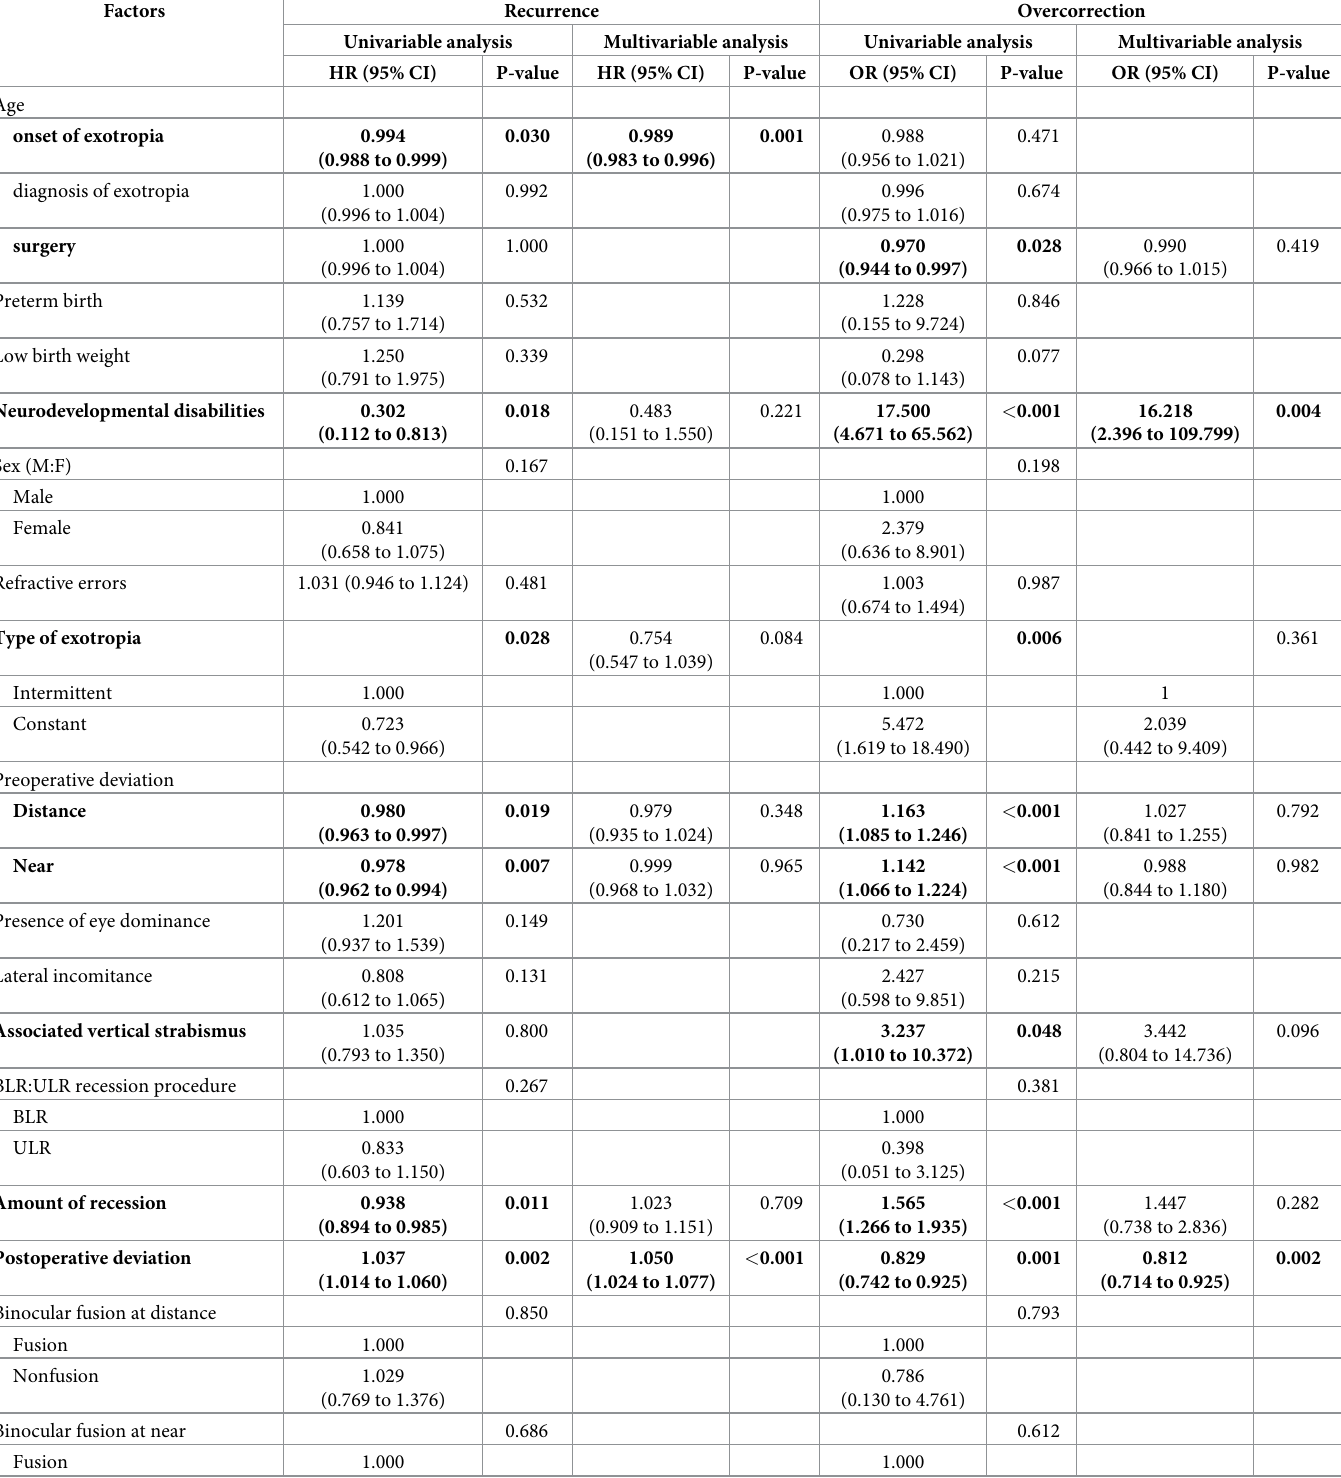
Table 4. Univariable and multivariable regression analyses for competing risk factors for overcorrection and